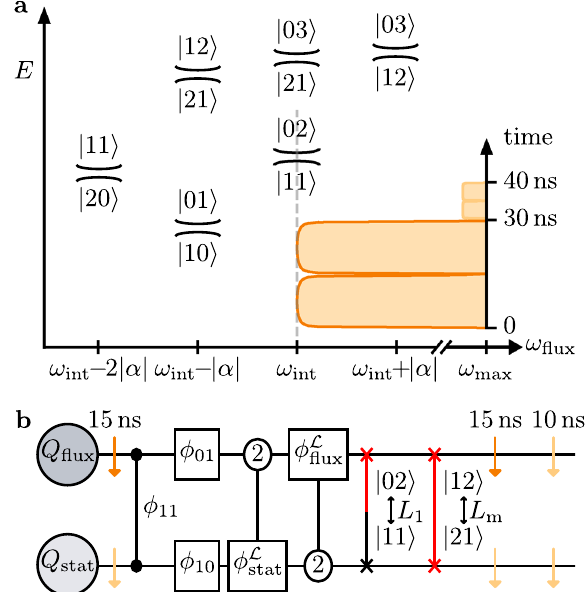
Fig. 1 CZ error model for two transmon qubits. Schematic of the relevant interactions and the CZ error model for two transmons, a higher frequency one Q fl ux and a lower frequency one Q stat . The inset of a shows the frequency excursion taken by ω Q fl ux from its sweetspot frequency max to the interaction frequency ω int , corresponding to the 11 j i $ 02 j i avoided cross- ing, followed by weaker single-qubit phase-correction pulses. During this excursion, the frequency ω stat of Q stat remains static at ω stat ¼ ω int (cid:2) α j j , where α is the anharmonicity. a Sketch of all the considered avoided crossings, with the two-qubit system energy E on the vertical axis versus the frequency ω fl ux of Q fl ux on the horizontal axis. b The parametrized CZ error model. An ideal CZ is constructed with the two-qubit phase ϕ 11 and the single- qubit phases ϕ 01 and ϕ 10 . It is followed by single-qubit rotations and ϕ L , conditioned on the other transmon with phases ϕ L flux stat being leaked, and by the SWAP-like exchanges with leakage probability L 1 and leakage-mobility probability L m (see section “ Leakage error model ” for precise de fi nitions). Relaxation and decoherence, indicated by the orange arrows, are taken into account as